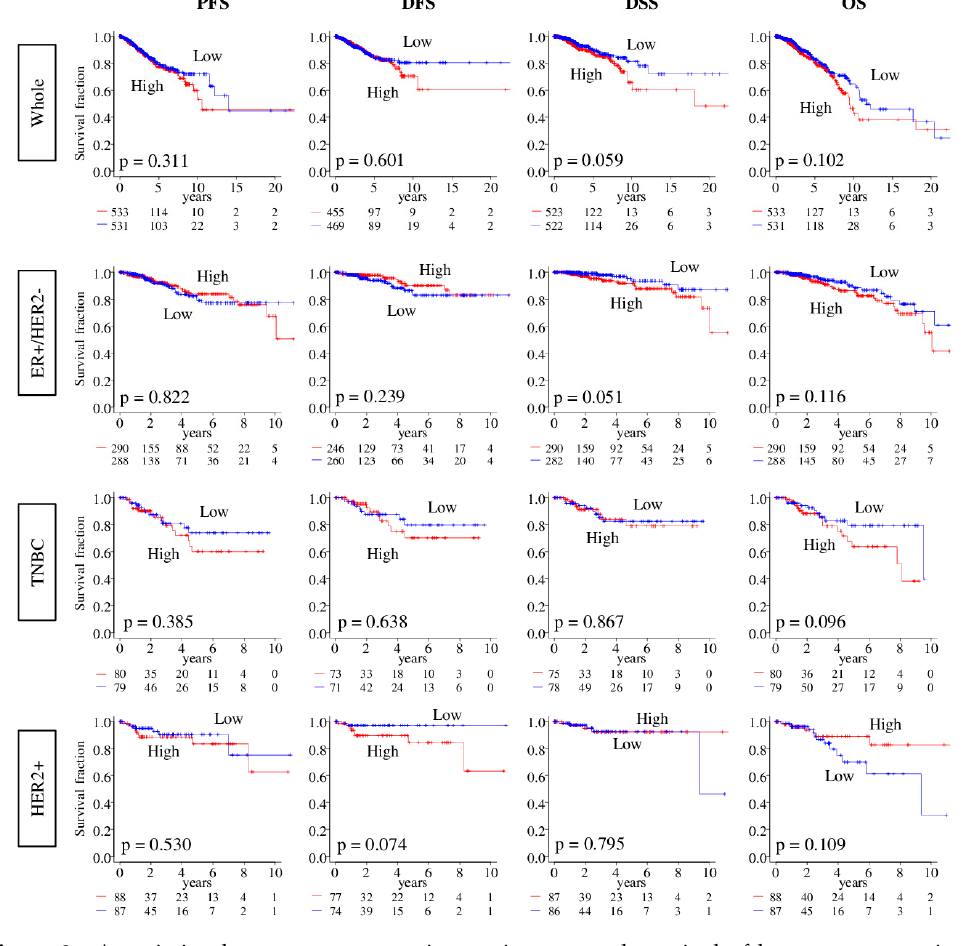
Figure 3. Association between tumor angiogenesis score and survival of breast cancer patients. Progression-free survival (PFS), Disease-Free (DFS), Disease-Specific (DSS), and Overall Survival (OS) of angiogenesis score low (blue) and high (red) in Whole breast cancer cohort, and each subtypes; estrogen receptor-positive/human epidermal growth factor receptor 2-negative (ER+/HER2-), triple negative breast cancer (TNBC), and HER2-positive, in the TCGA cohorts. The median was used as cut-off to divide into high and low score groups within each cohort. Log rank test was used to compare between two groups with Kaplan–Meier survival curves and to calculate p values.